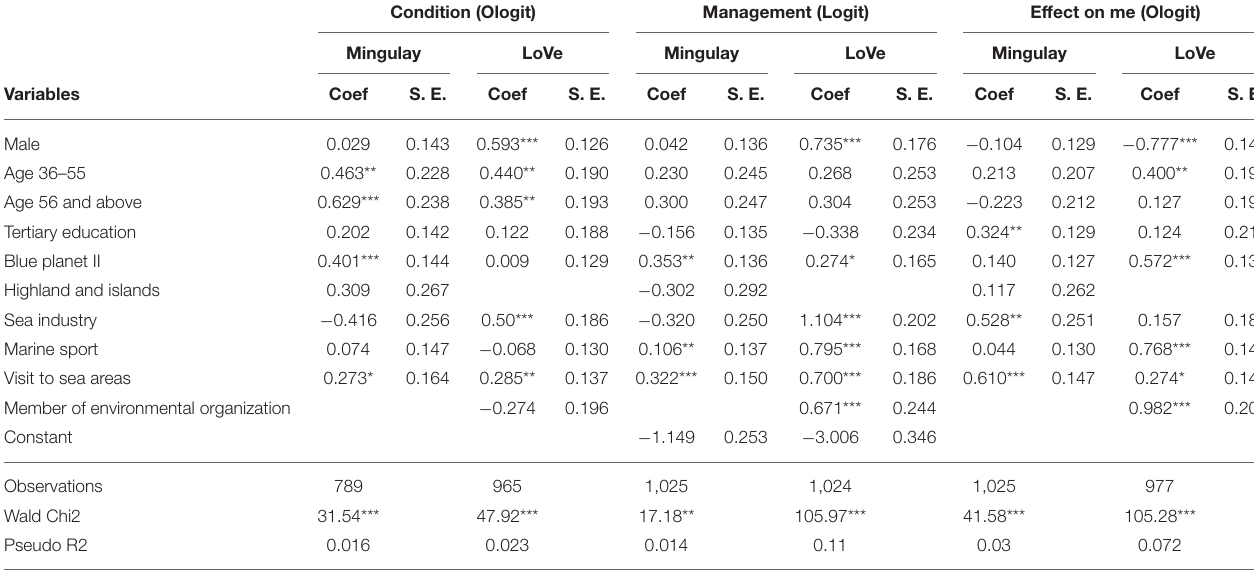
TABLE 4 | Influencers of perceived deep-sea condition, management, and personal